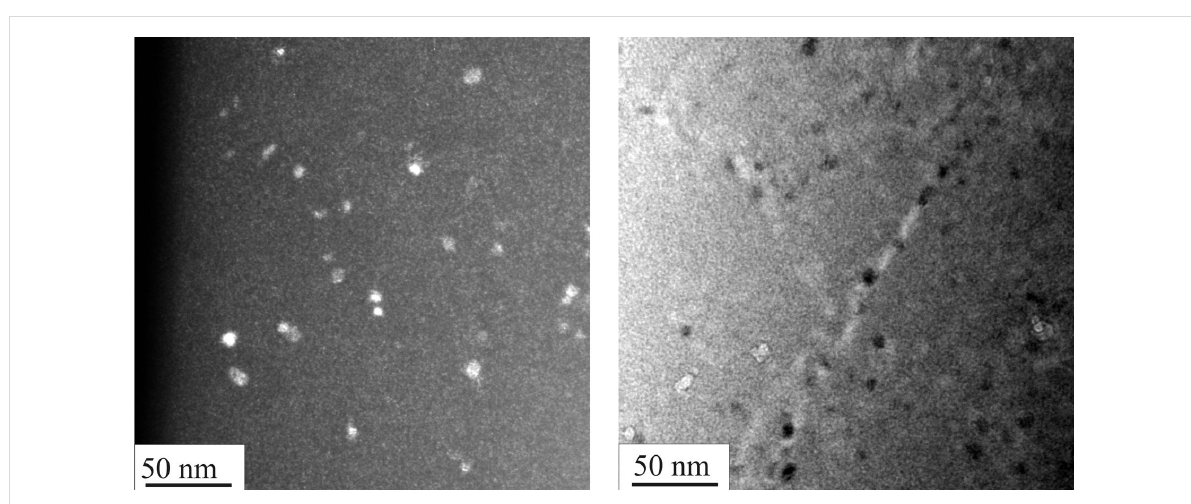
Figure 6: DF TEM (left) and BF TEM (right) after 210 °C anneal of cold-rolled sample.